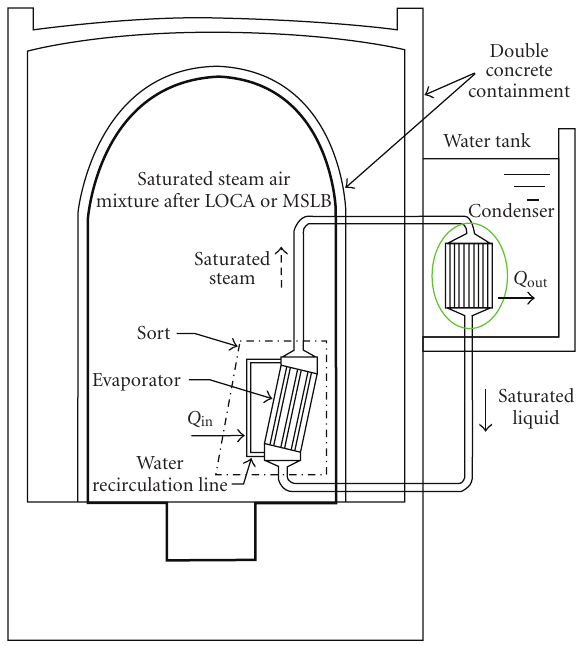
Figure 3: PCCS condenser of the